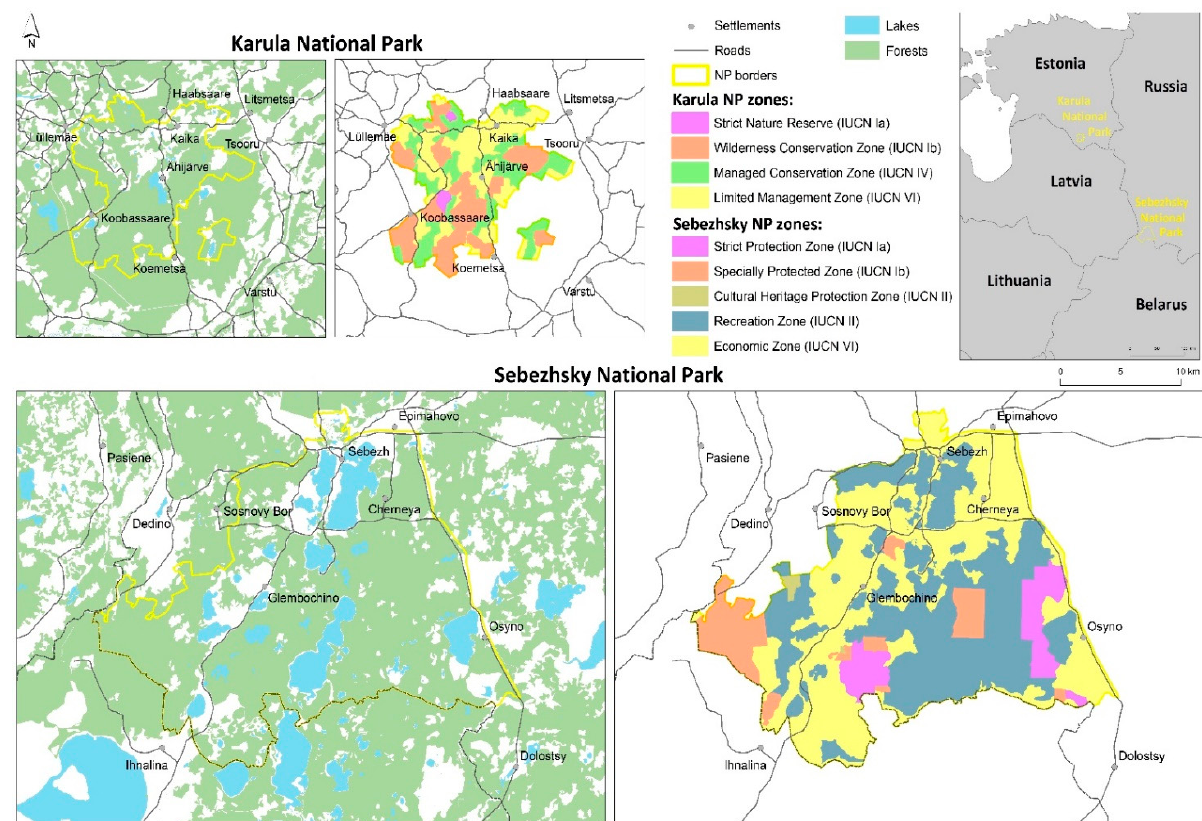
Figure 1. Locations and zoning of Karula national park (NP) in southern Estonia and Sebezhsky NP in the south of Pskov Region of Russia.